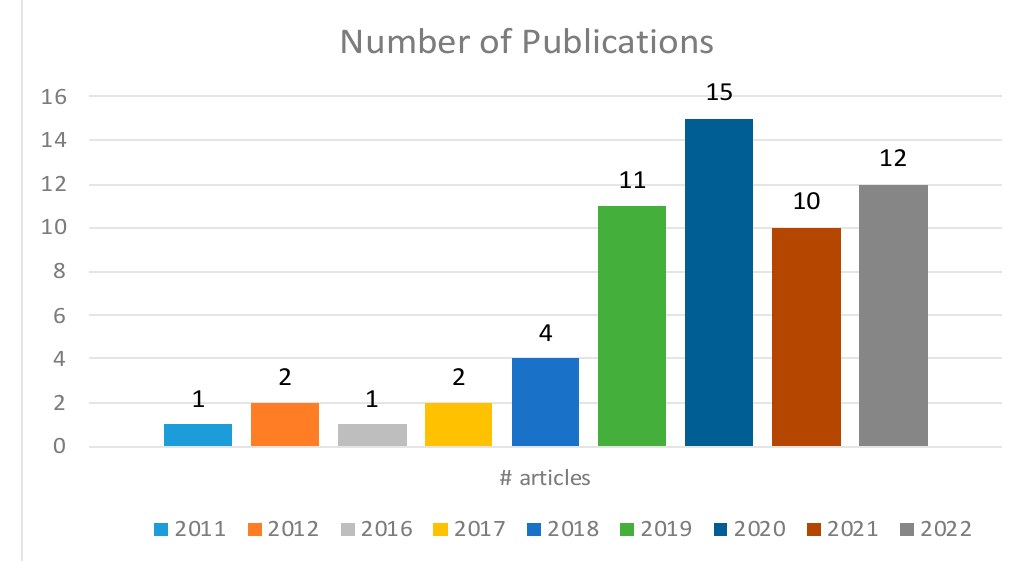
Figure 3. Number of papers versus publication year of the articles in Energies.